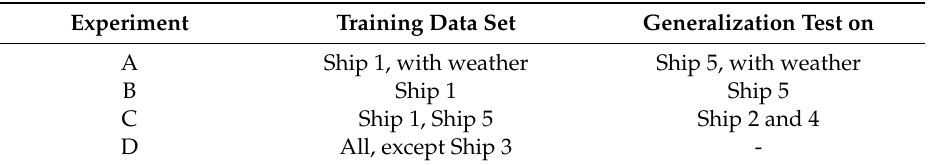
Table 5. Evaluation